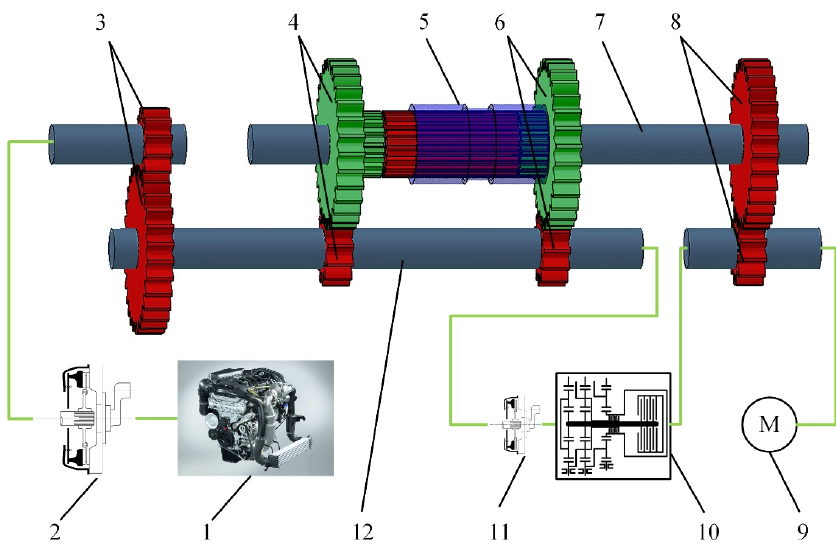
Figure 1. Simplified diagram of automatic mechanical transmission (AMT) with the gearshift assistant mechanism concept. 1: Inner combustion engine; 2: Main clutch; 3: Gear pair connect the engine output shaft and the secondary shaft; 4: Anticipated gear pair; 5: Synchronizer; 6: Present gear pair; 7: Primary shaft (output shaft); 8: Complementary gears; 9: Torque complementary motor; 10: Epicyclic mechanism; 11: Synchronizing clutch; 12: Secondary shaft.